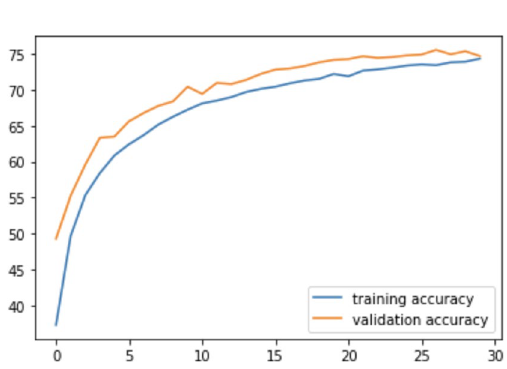
Fig. 10 Training-validation